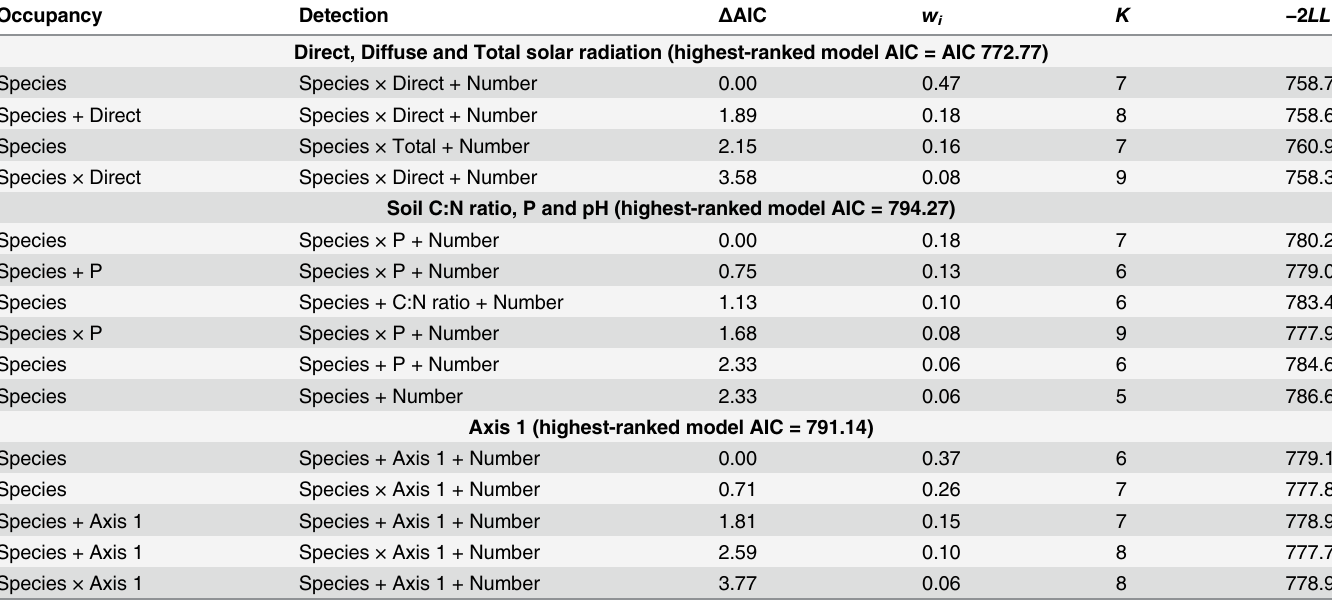
Table 4. Two-species occupancy models for rusa deer and red deer camera trap data collected in summer 2011.